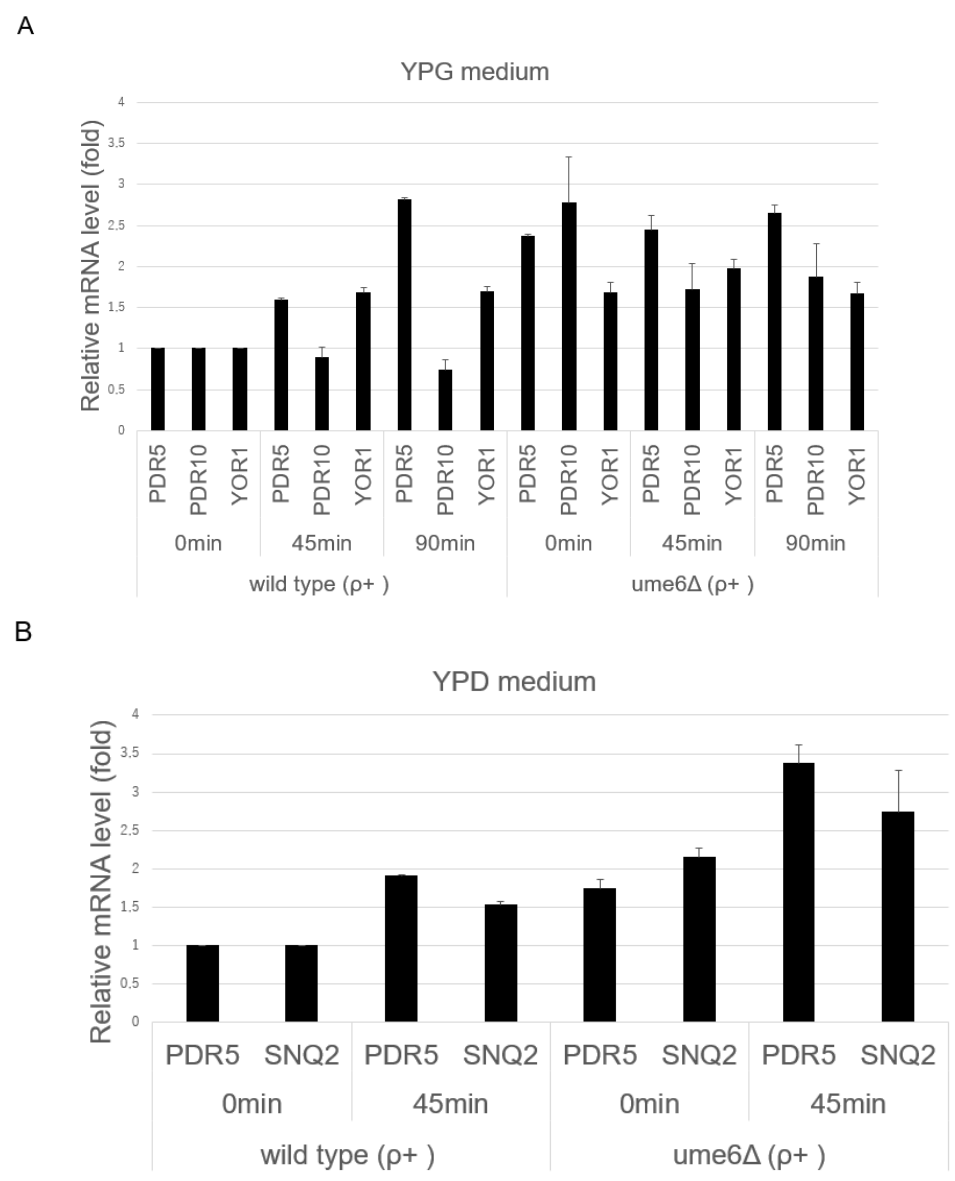
Figure 4. Changes in the transcriptional expression of PDR5, PDR10, YOR1, and SNQ2 in the ρ + cells of the wild-type and ume6 ∆ strains in YPG and YPD media after the addition of cycloheximide. ( A ) The relative fold levels of PDR5, PDR10, and YOR1 mRNA in the ρ + cells of the wild-type and ume6 ∆ strains after exposure to cycloheximide (0.2 μ g/mL) for 45 min and 90 min in YPG medium were quantified by qRT-PCR. ( B ) The relative fold levels of PDR5 and SNQ2 mRNA in the ρ + cells of the wild-type and ume6 ∆ strains at 45 min after the addition of cycloheximide (0.2 μ g/mL) in YPD medium were quantified by qRT-PCR.